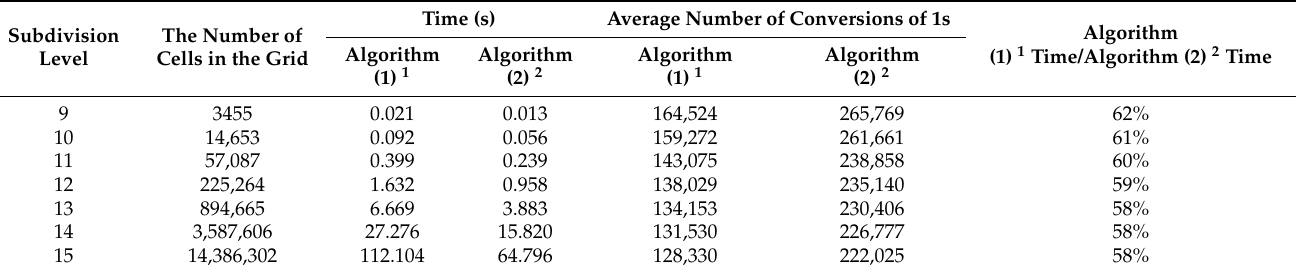
1 Resampling conversion algorithm. 2 Hierarchical conversion algorithm. Table 9. Comparison table of the algorithms efficiency of conversion from Goodchild encoding to quaternary encoding.